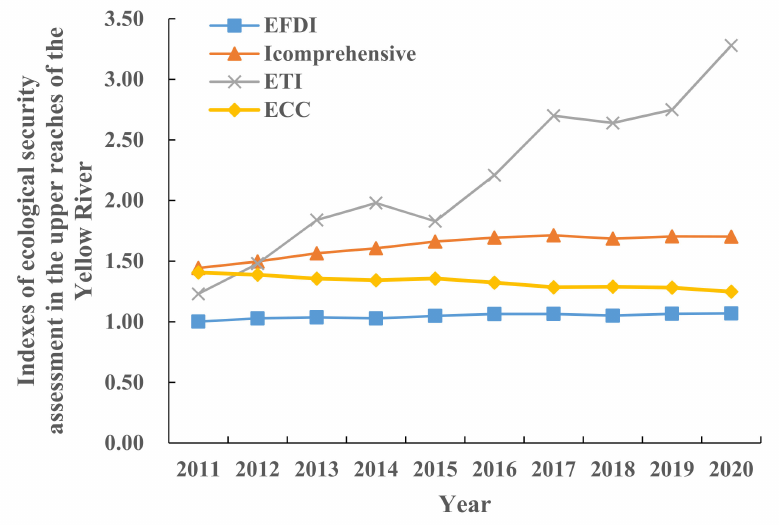
Figure 6. Index values of ecological security assessment of the upper reaches of the Yellow River from 2011 to